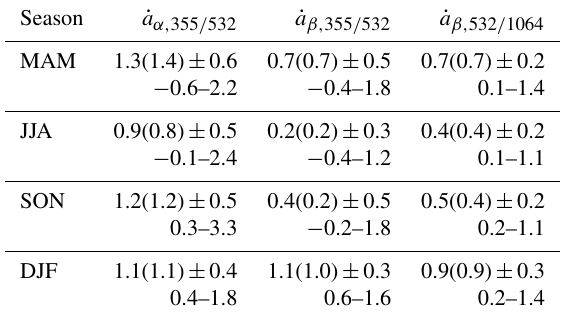
Table 4. Seasonal mean(median) values ± SD of backscatter-related ( ˙ a β, 355 / 532 , ˙ a β, 532 / 1064 ) and extinction-related ( ˙ a α, 355 / 532 ) Ångström exponents. The range of the values from minimum to maximum is given in the second